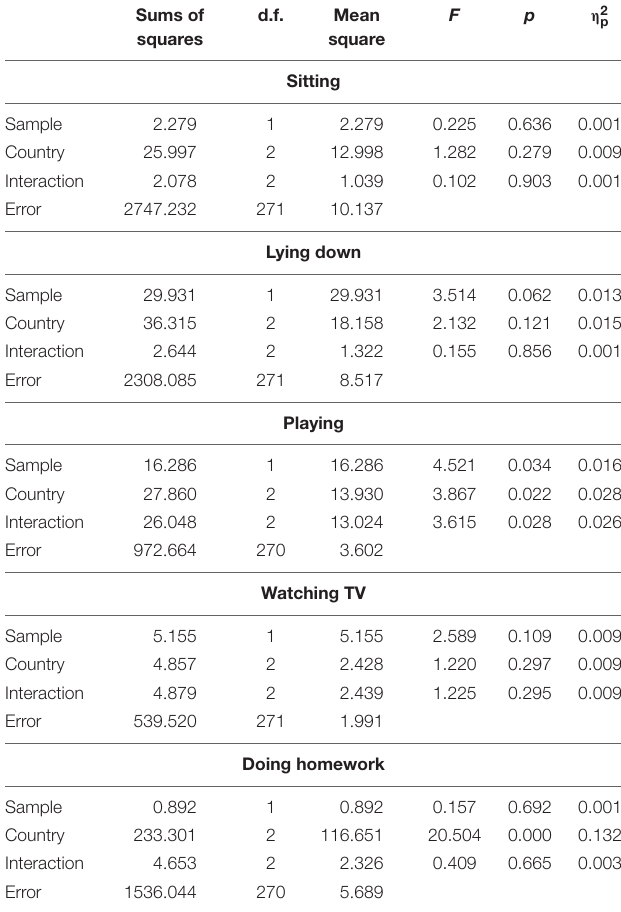
TABLE 8 | ANOVA of physical activity by sample and country of residence. Sums of squares